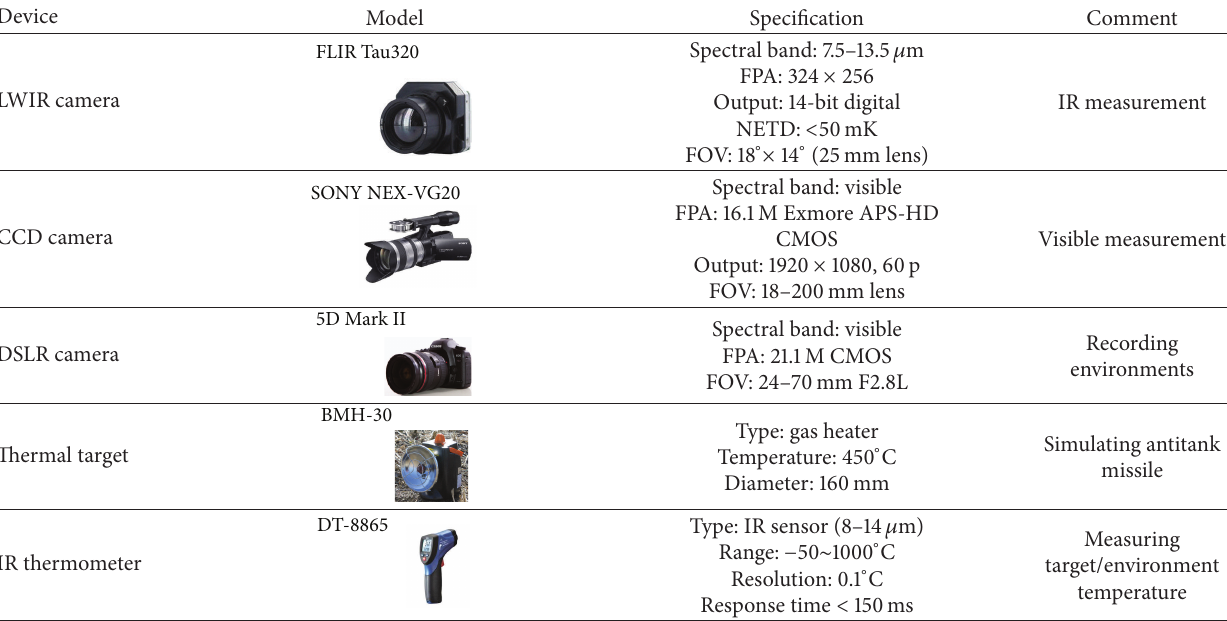
Table 1: Measurement sensors used during 24-hour recording.